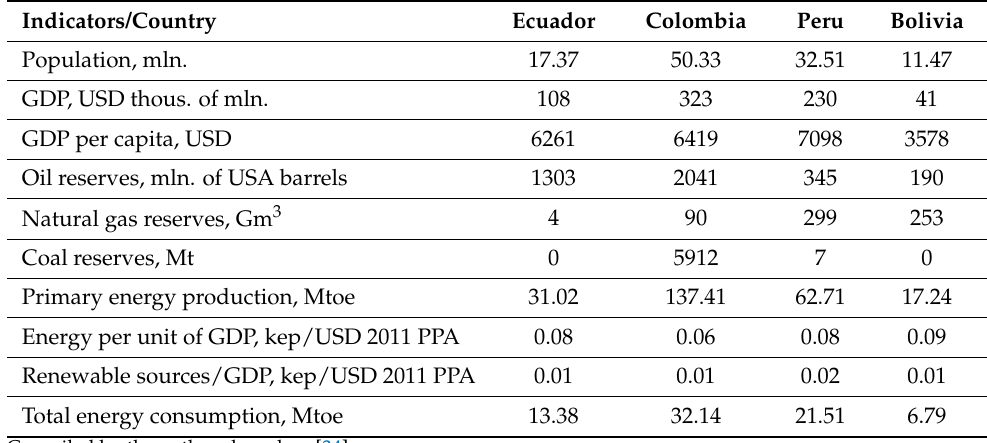
Table 1. Key development indicators of the Andean Community members as of 2019. Indicators/Country Ecuador Colombia Peru Bolivia Population, mln. 17.37 50.33 32.51 11.47 GDP, USD thous. of mln. 108 323 230 41 GDP per capita, USD 6261 6419 7098 3578 Oil reserves, mln. of USA barrels 1303 2041 345 190 Natural gas reserves, Gm 3 4 90 299 253 Coal reserves, Mt 0 5912 7 0 Primary energy production, Mtoe 31.02 137.41 62.71 17.24 Energy per unit of GDP, kep/USD 2011 PPA 0.08 0.06 0.08 0.09 Renewable sources/GDP, kep/USD 2011 PPA 0.01 0.01 0.02 0.01 Total energy consumption,